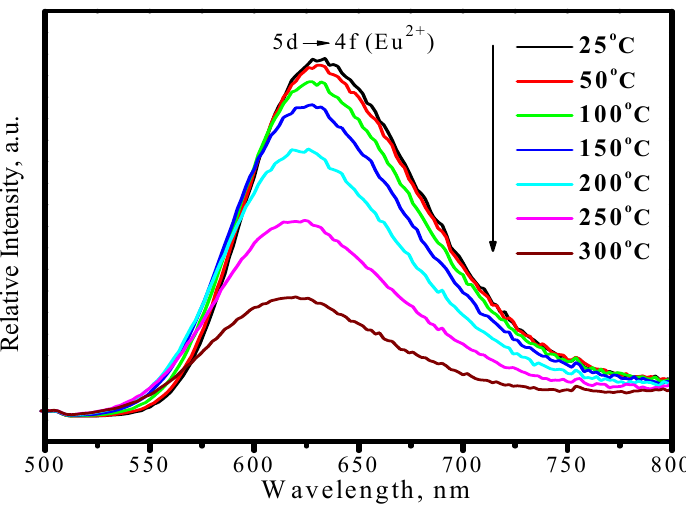
Ba Eu ) Si N under 460 nm excitation as 0.82 0.15 0.03 2 5 8